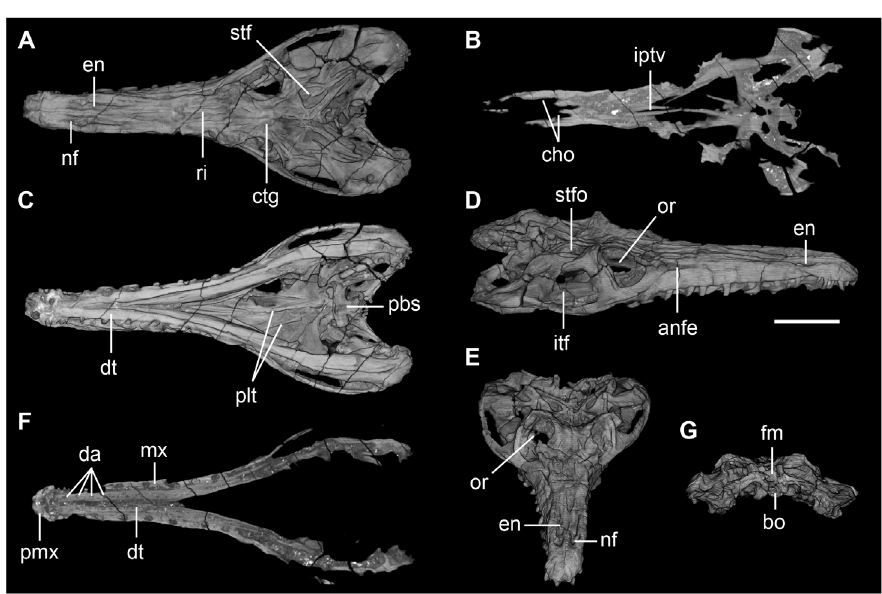
Figure 3. CT-scan slices and 3D reconstruction of the skull of Pseudochampsa ischigualastensis (PVSJ 567) in (A) dorsal view, (B) slice at level of the palate, (C) ventral, (D) dorsolateral, (E) and anterodorsal view, (F) slice at level of the dentary alveoli, and (G) occipital view. Abbreviations: anfe, antorbital fenestra; bo, basioccipital; cho, choanae; ctg, centre of growth; da, dentary alveoli; dt, dentary; en, external naris; iptv, interpterygoid vacuity; itf, infratemporal fenestra; fm, foramen magnum; mx, maxilla; nf, narial fossa; or, orbit; pbs, parabasisphenoid; pmx, premaxilla; plt, palate teeth; ri, ridge; stf, supratemporal fenestra, stfo, supratemporal fossa. Scale bar equals 5